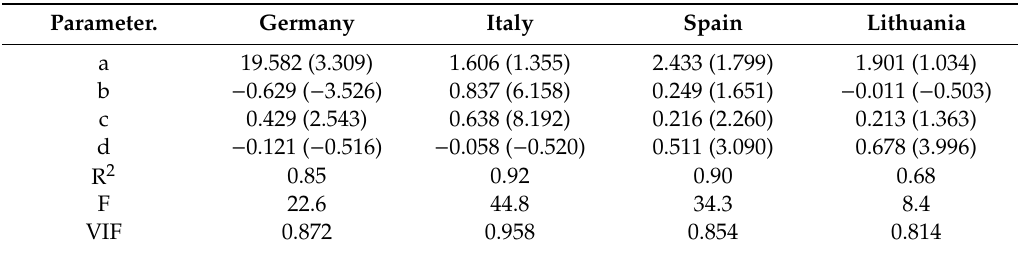
Table 2. Regression coe ffi cients for the analyzed countries. Corresponding t-values are reported in parentheses. Parameter. Germany Italy